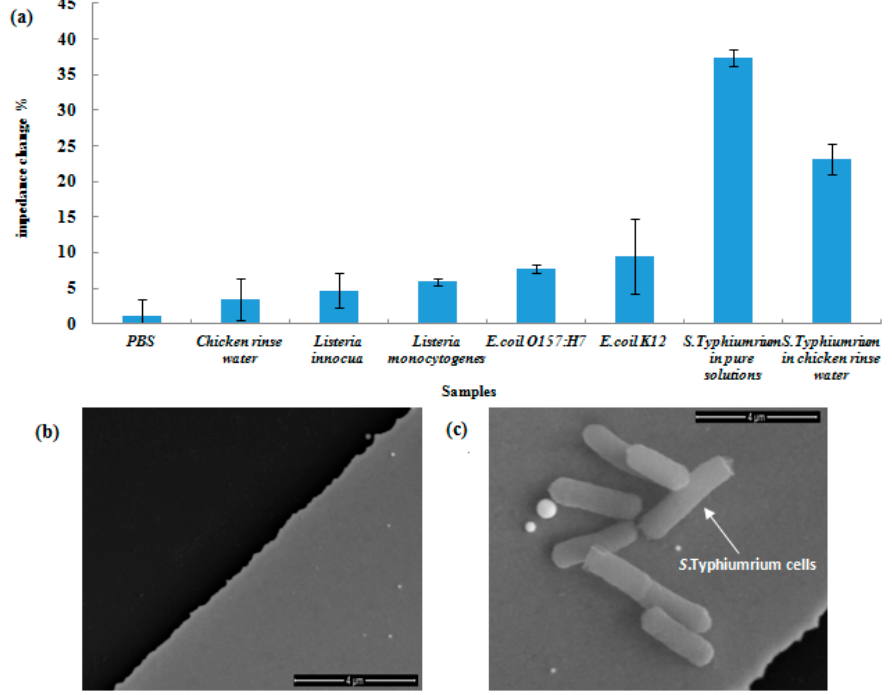
Figure 8. ( a ) Specificity tests of four non-target bacteria and detection of chicken rinse water, ( b ) SEM images of antibodies immobilized IDAM, and ( c ) S . Typhimurium cells captured by the antibodies which were immobilized on the IDAM